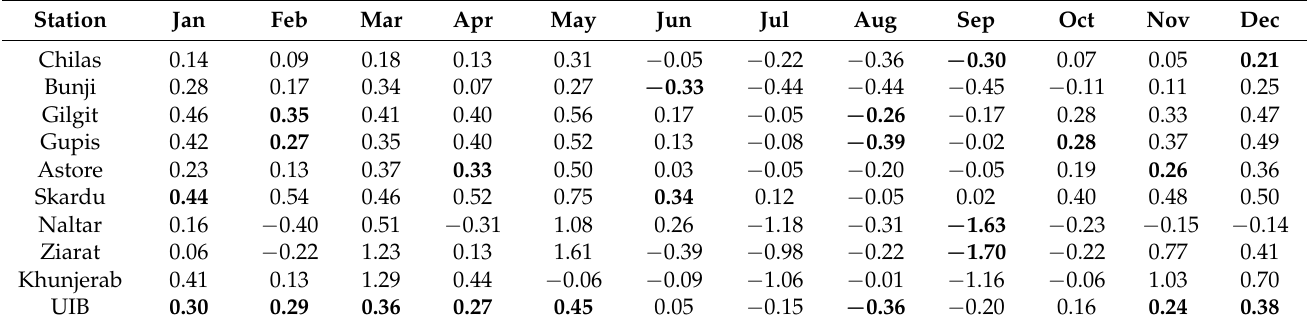
Table 2. Sen’s estimator for monthly T max ( ◦ C/decade). Bold indicates significant trend at 5% level.